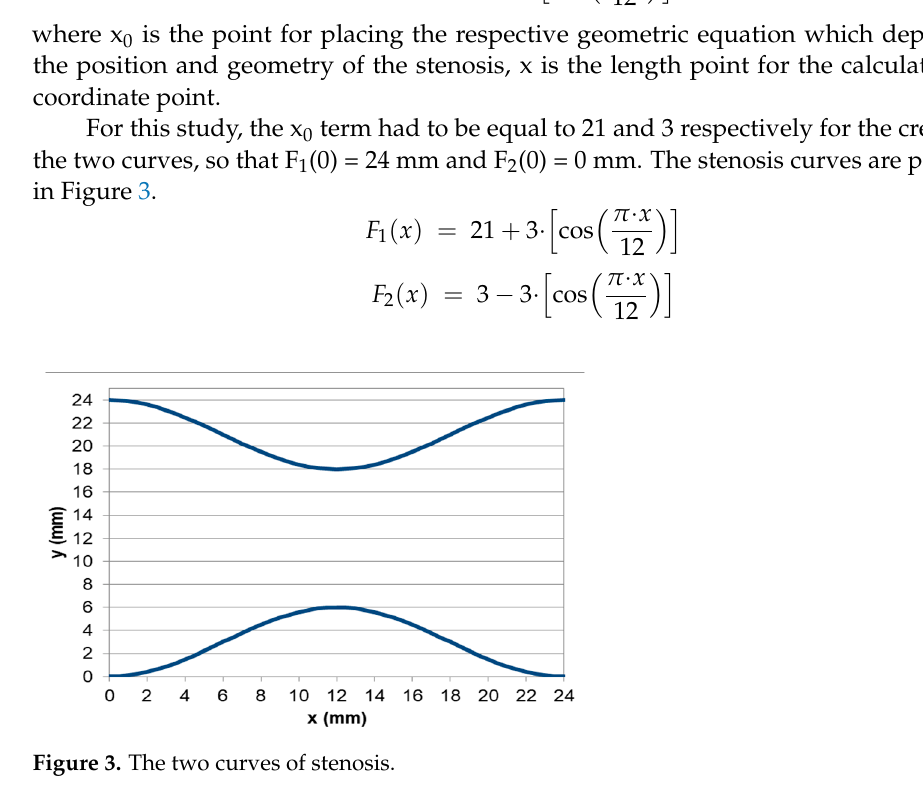
Figure 2. Experimental part and 3D geometry of the aorta with stenosis and anastomosis regions.